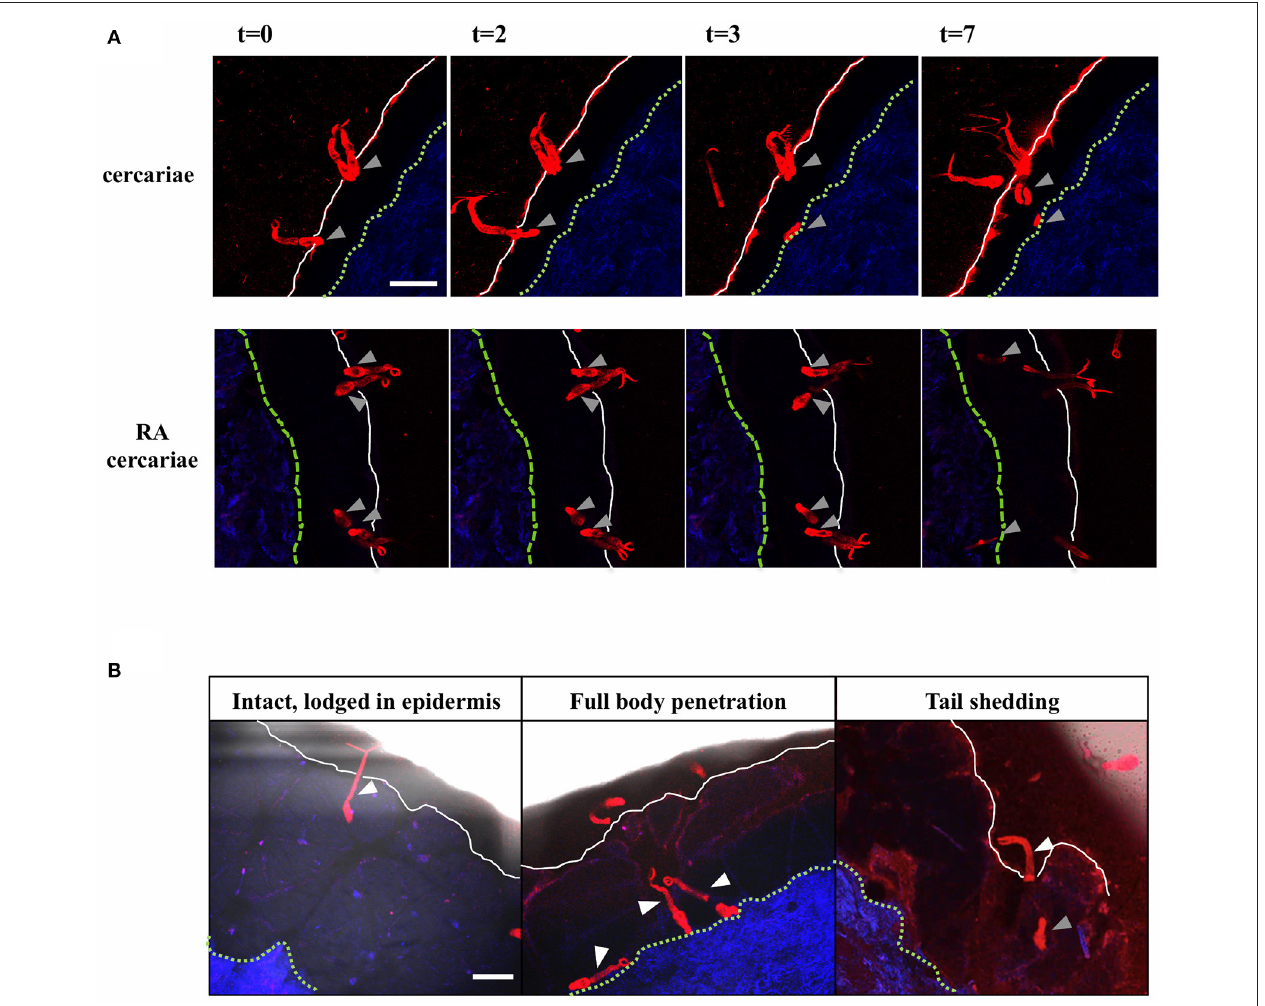
FIGURE 2 | Visualization of cercarial invasion into a human skin explant. Cercariae attach and penetrate the epidermis of the human skin explant. Cercariae depicted in red, the dermis in blue, the epidermal surface as a white solid line and the basal membrane as a green dashed line T = 0–7min. Gray arrowheads: cercarial heads/schistosomula. Top panels: non-attenuated cercariae, lower panels: RA cercariae (A) . Cercariae penetrate the skin in different ways. White arrowheads: cercariae/tails ( B ). Scale bar: 200 µ m.